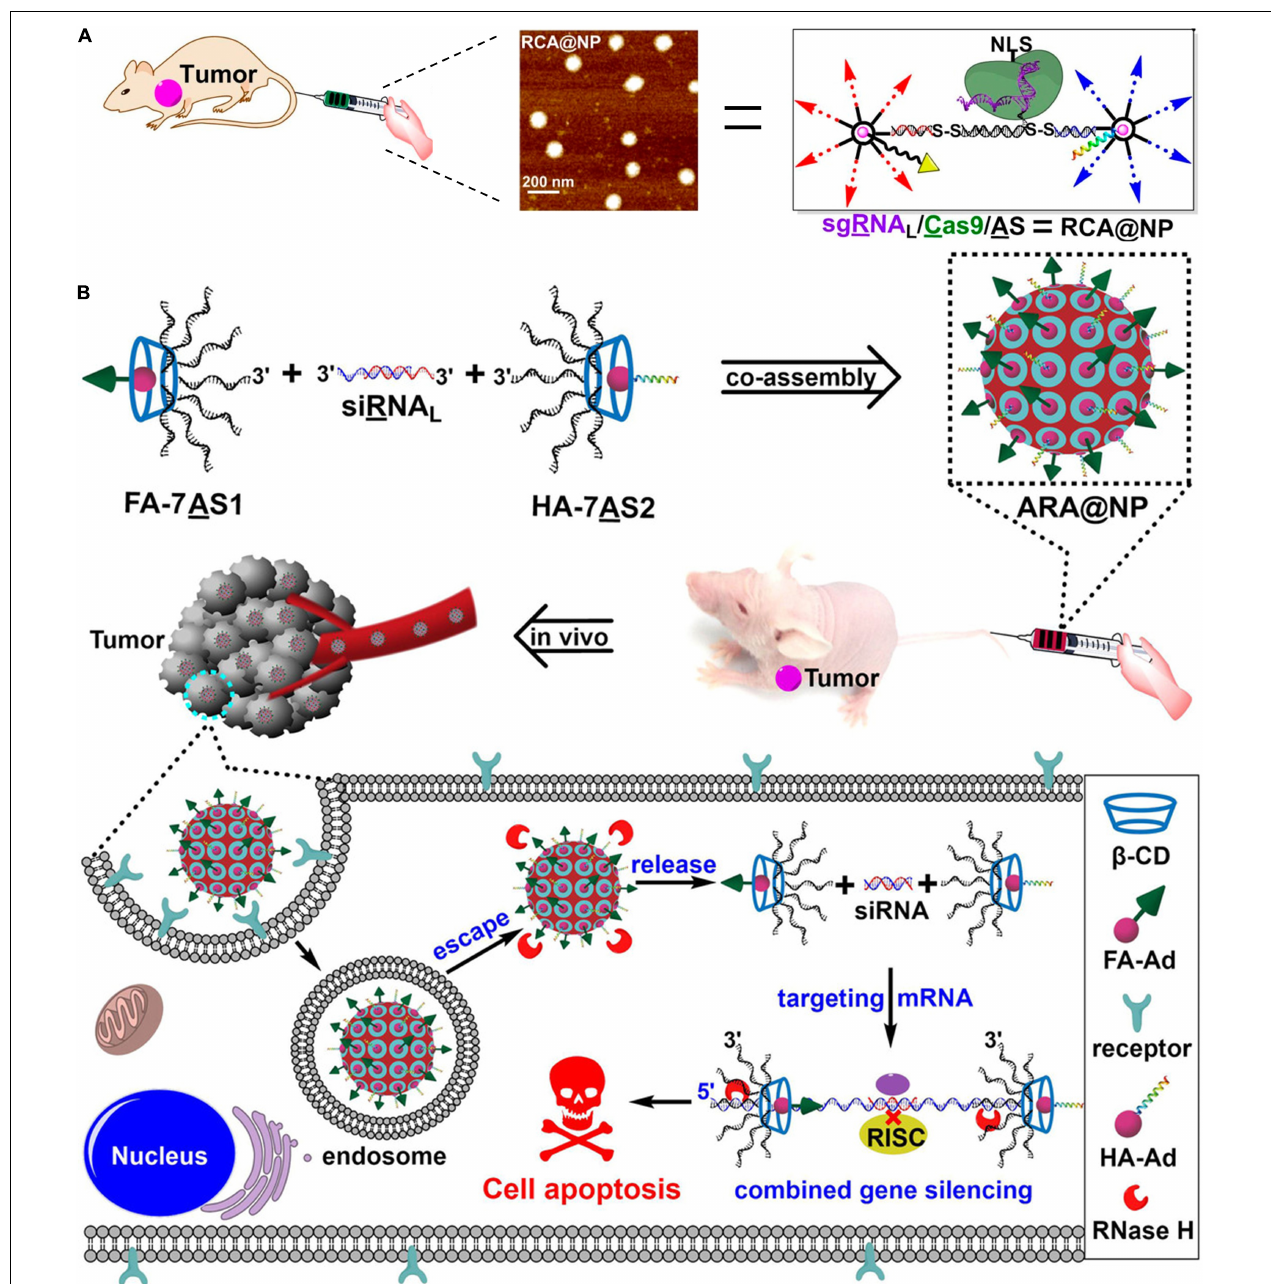
FIGURE 5 | DNA-supermolecule nanoassembly for nucleic acid delivery. (A) Multifunctional nucleic acid nanostructures for sgRNA/Cas9/antisense delivery. Adapted with permission from ref. Liu et al. (2019). Copyright 2019, American Chemical Society. (B) Crosslinked nucleic acid nanogel for effective siRNA delivery. (B) Co-assembly of branched antisense and siRNA for combined gene silencing and tumor therapy. Adapted with permission from ref. Liu et al. (2021). Copyright 2020, Wiley-VCH.